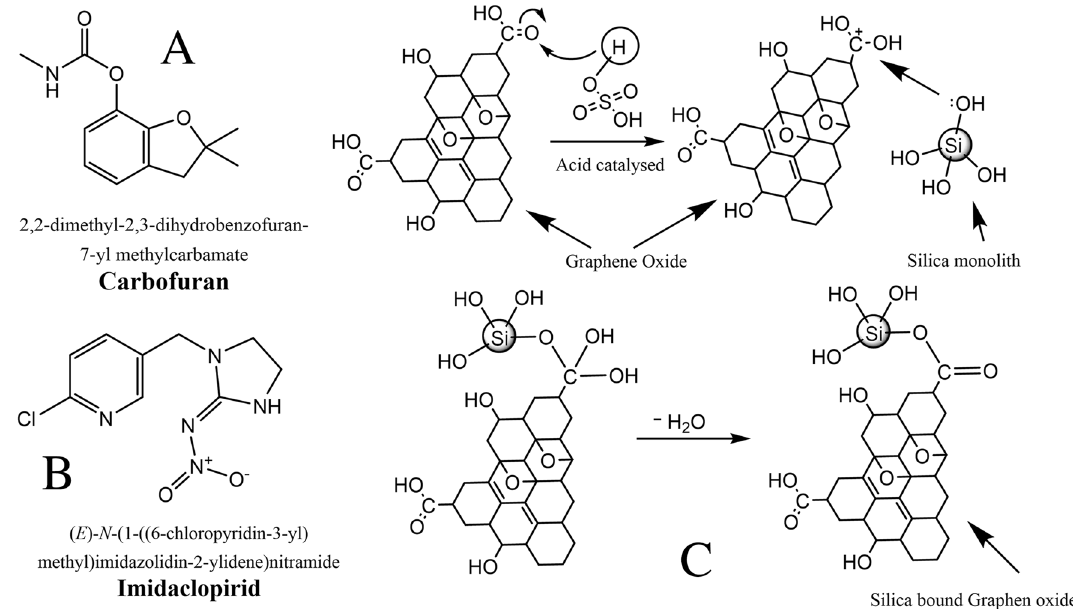
Figure 1. Structures of carbofuran ( A ) and imidacloprid ( B ), Scheme for the Synthesis of composite availing the Fisher Esterification protocol ( C